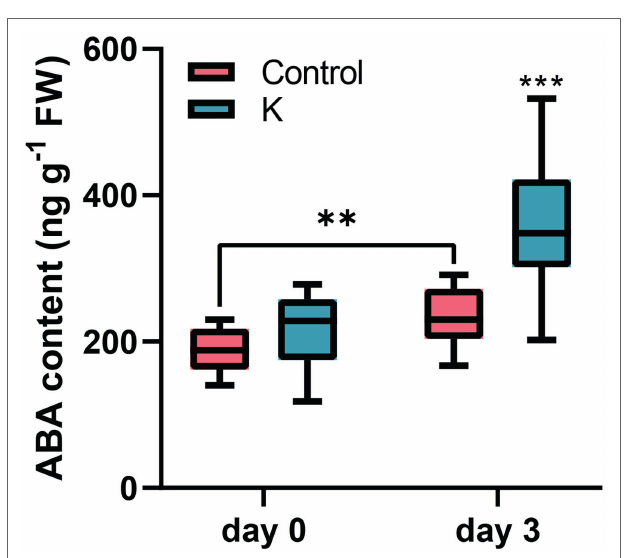
FIGURE 8 | Effect of Mucilaginibacter sp. K on endogenous ABA content. The measurements were taken on 14-day-old seedlings (day 0) and 3 days after salt initiation. The increasing ABA content in salt-stressed maize seedlings pre-treated with strain K is greater than that in the control. Box plots show group median and interquartile range ( ** p < 0.01 and *** p <